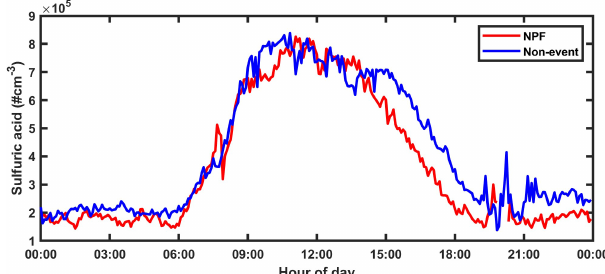
Figure 2. Averaged diurnal cycles of sulfuric acid concentrations for NPF days and non-event days during the 26d measurement pe- riod.